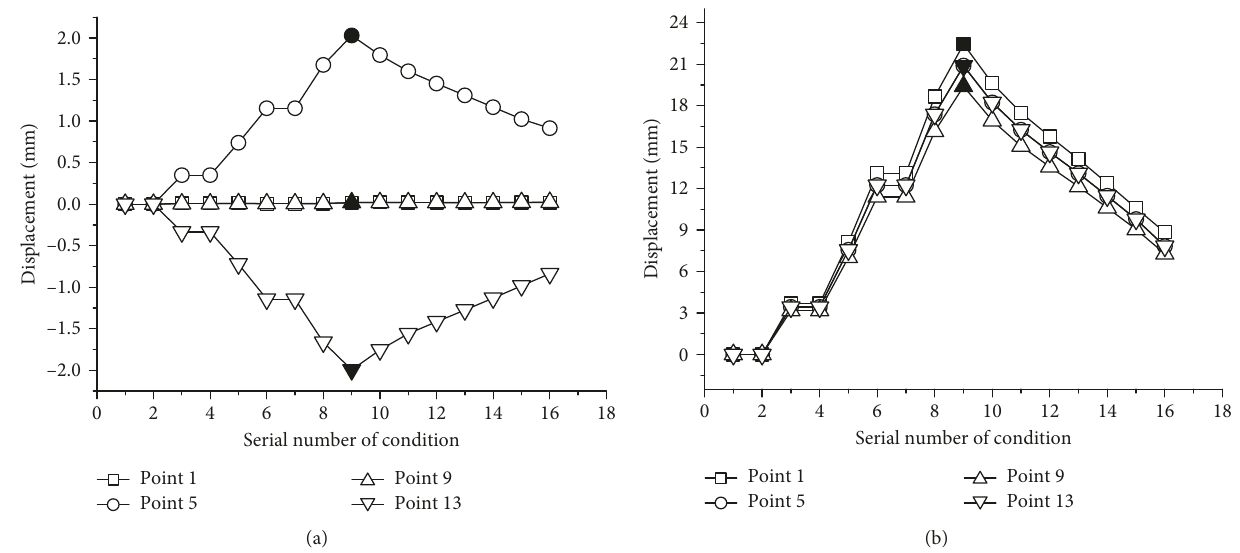
Figure 9: Time history of displacement of the tunnel in Scheme 1. (a) Horizontal displacement. (b) Vertical displacement.